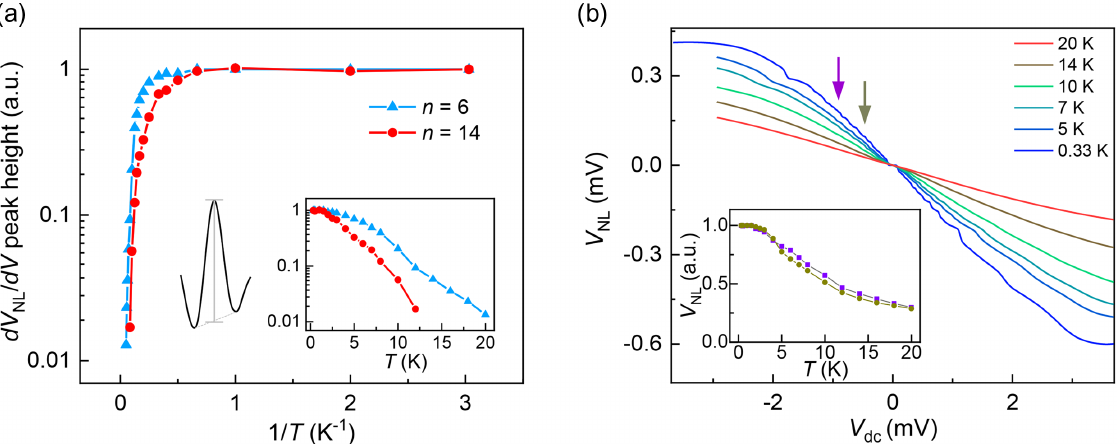
=dV peak height as illustrated vs T in an Arrhenius plot for NL ’ s marked by the ( T ) at two V NL dc